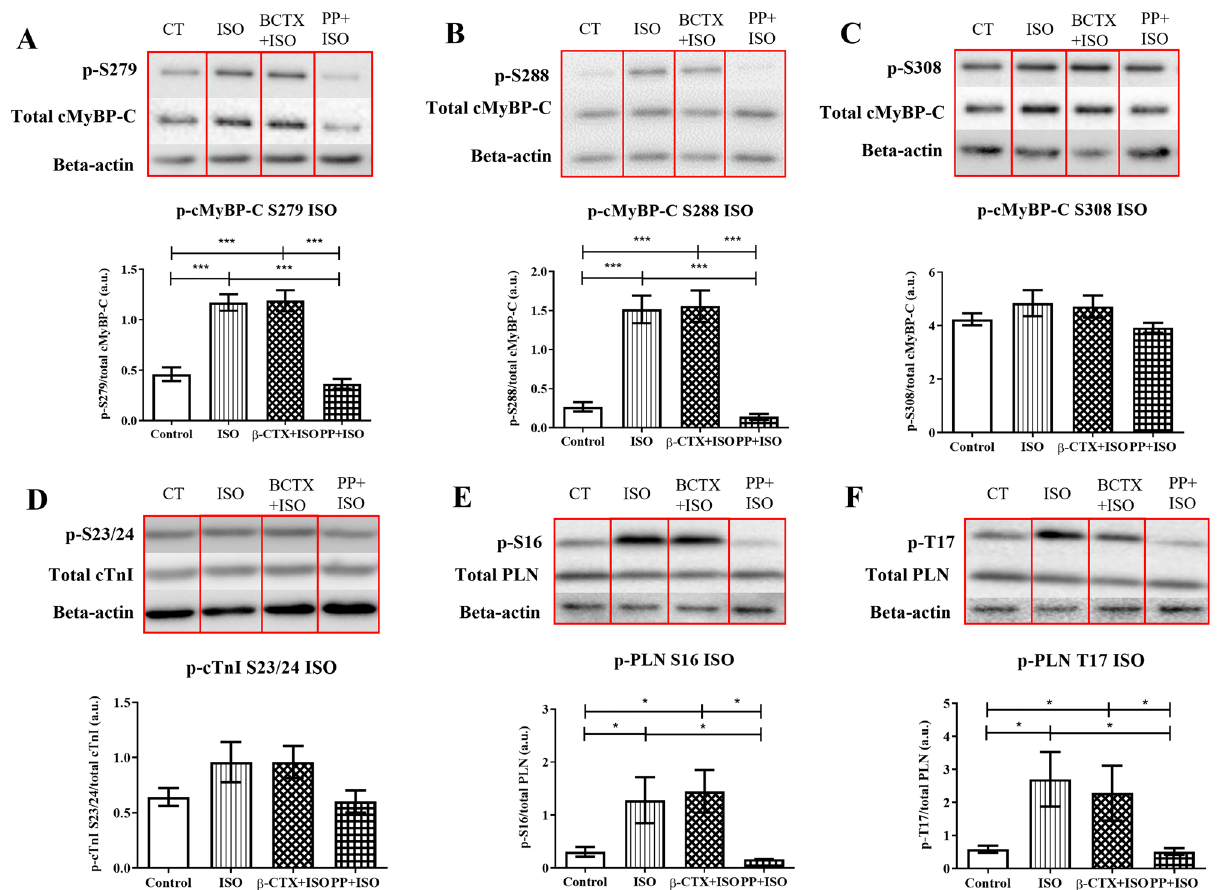
Figure 5. Comparison of specific phosphorylation sites of proteins involving in β-adrenergic signaling after incubated cardiomyocytes with control solution, ISO only, PP + ISO, and β-CTX + ISO (n = 6 each). The grouping of gels/blots cropped from different parts of the same gel. Uncropped blots are available in supplementary (Figure S6 and S7). Representative cropped blots are shown above their corresponding bar graphs. Data are demonstrated as mean ± S.E.M. of the ( A ) p-S279, ( B ) p-S288 and ( C ) p-S308 of cardiac myosin binding protein-C (cMyBP-C), (D) p-S23/24 of cardiac troponin I (cTnI), and (G) p-S16 and (H) p-T17 of